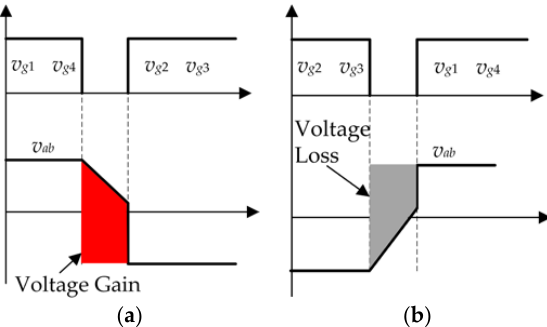
Figure 6. NZVS fails when the load current is small enough: ( a ) i o > 0 and ( b ) i o < 0.